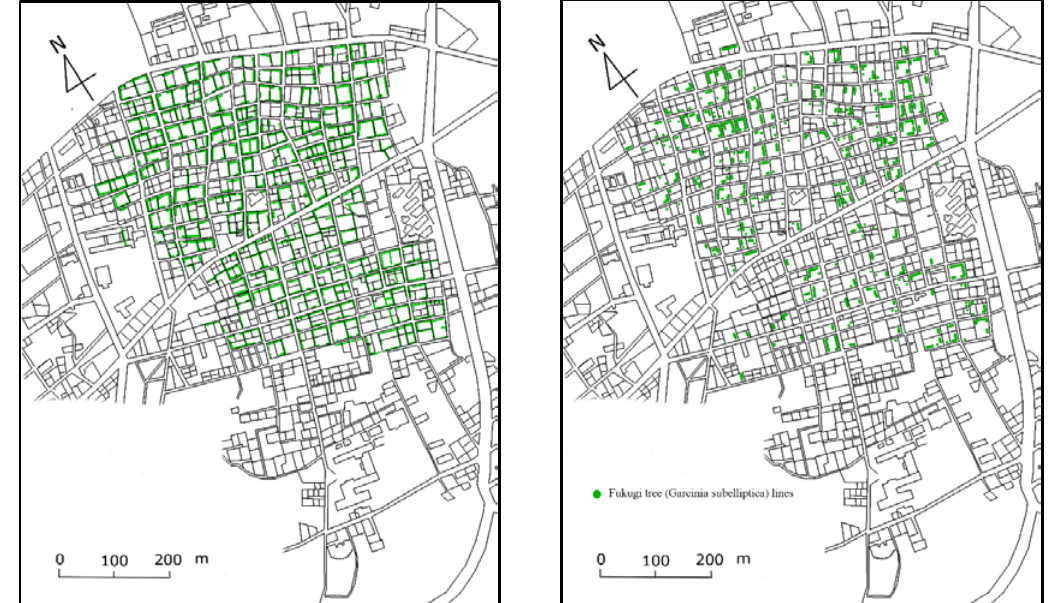
Figure 5. Remnant Fukugi tree lines in ( left ) 1945 and in ( right ) 2017. Identified Fukugi tree lines marked in green.